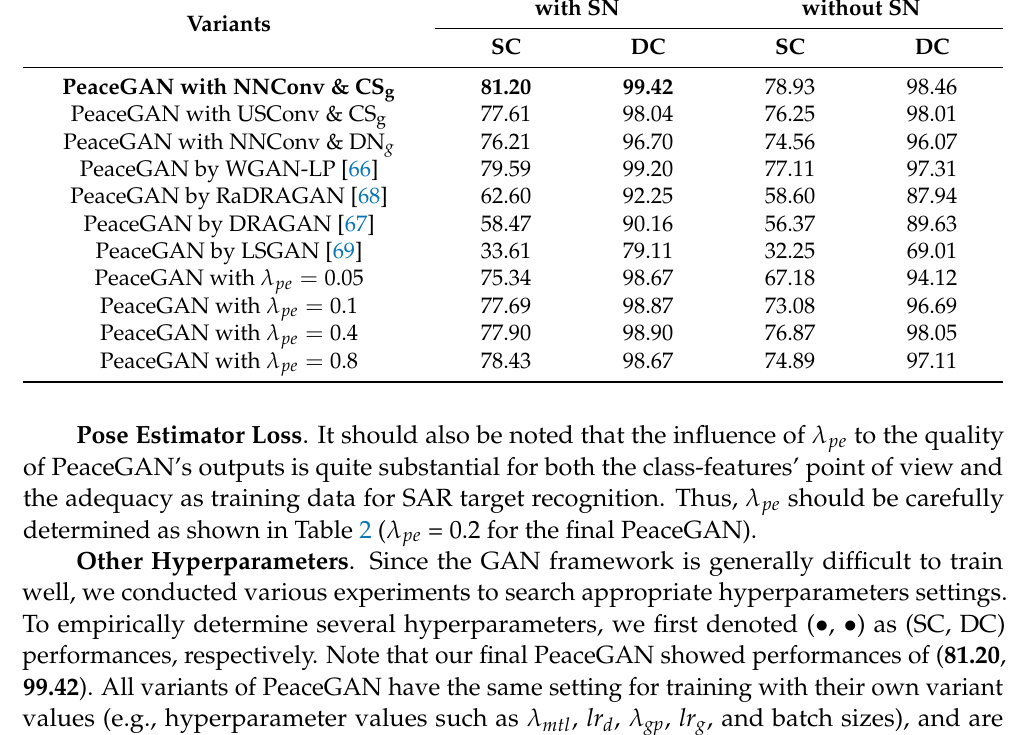
Table 2. Target recognition performance (%) for PeaceGAN variants indirectly evaluated by the SC and DC methods. with SN without SN Variants SC DC SC DC PeaceGAN with NNConv & CS